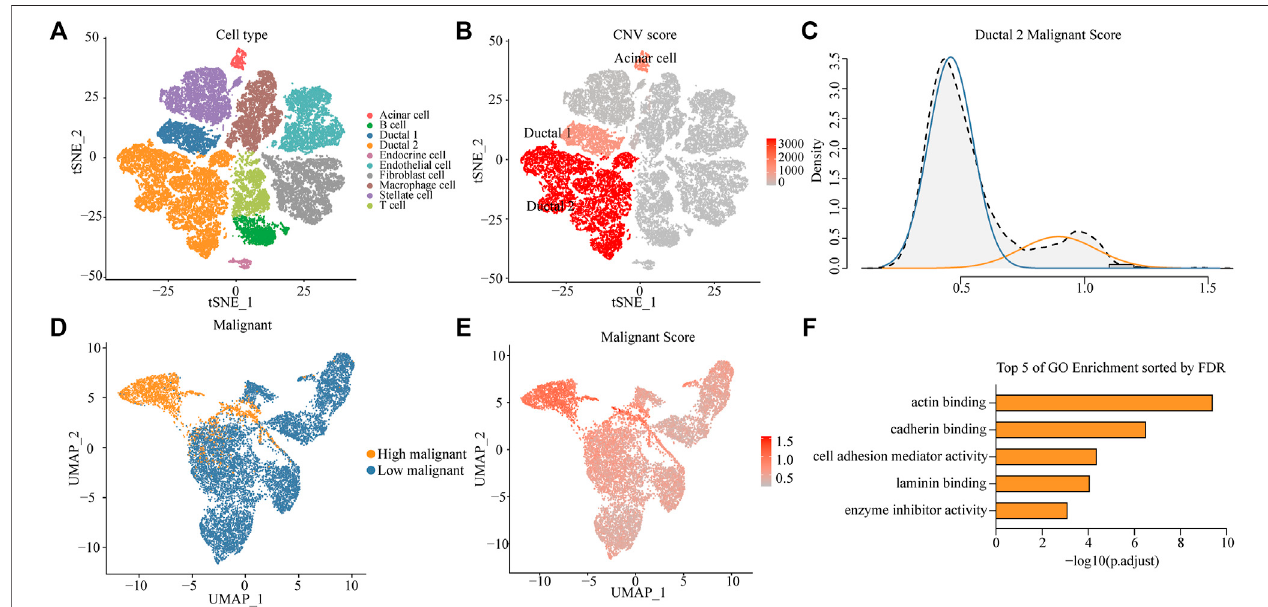
FIGURE1| Identifyingahighly malignant cellsubpopulation inPDAC. (A) t-SNEdimensionalreductionofgeneexpression in40,986cellsshowingmajorcelltypes in 24 patients with PDAC. (B) Copy number variation (CNV) scores of ductal 1, ductal 2, and acinar cells via t-SNE analysis. (C) A density graph of malignant scores in ductal 2 cells. (D) UMAP plots comparing highly malignant and lowly malignant cells in ductal 2 cells. (E) UMAP plots of corresponding malignant scores levels [scaled from low (gray) to high (red)]. (F) Bar chart of highly malignant cell biological process (BP) GO terms (at most fi ve) ranked by the FDR ( p <